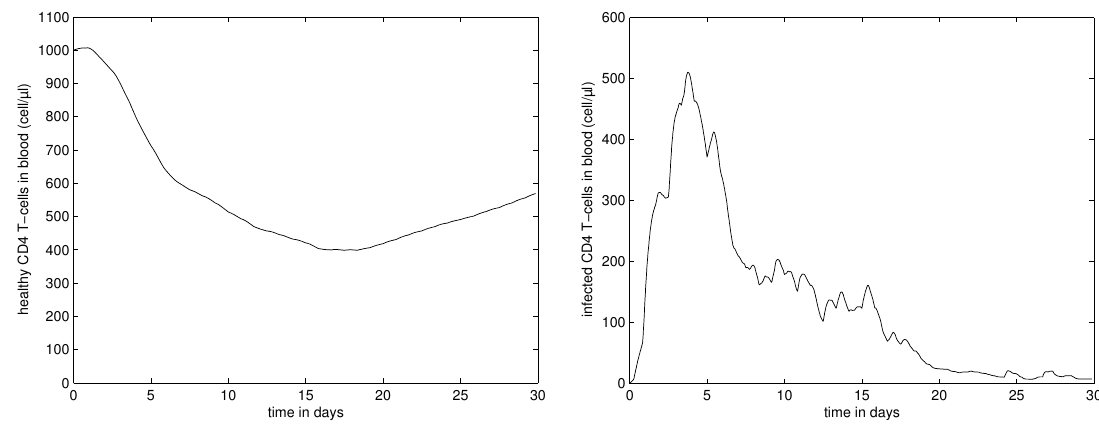
Figure 12. Dynamics of infection in blood. ( left ) The population of uninfected CD4 + T cells (cell/ µ L); ( right ) The population of infected CD4 + T cells (cell/ µ L).